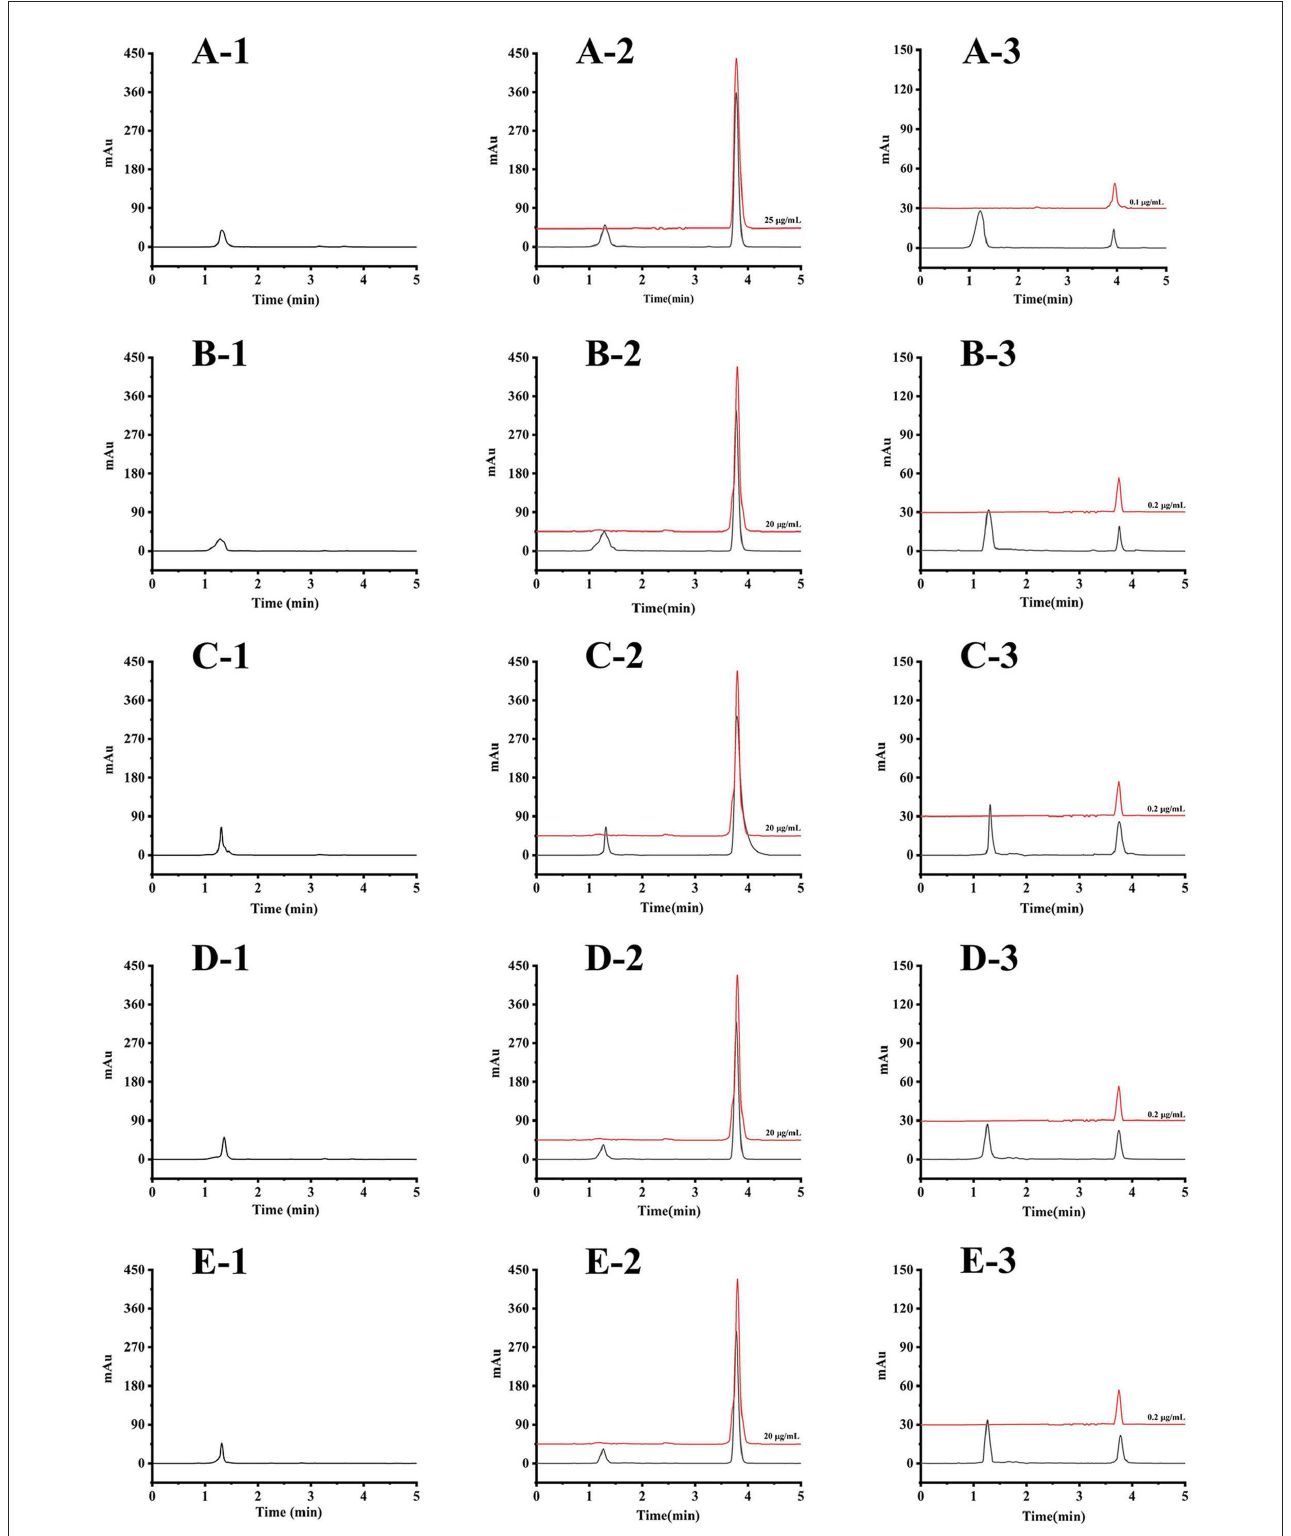
FIGURE1 The HPLC chromatograms of blank carp matrices spiked matrices (black line) and the corresponding standard solution (red line): (A-1) blank plasma, (A-2) plasma spiked at 10 µ g/ml and the standard solution of 25 µ g/ml, (A-3) plasma spiked at LOQ concentration and the standard solution of 0.1 µ g/ml; (B-1) blank muscle, (B-2) muscle spiked at 5 µ g/g and the standard solution of 20 µ g/ml, (B-3) muscle spiked at LOQ concentration and the standard solution of 0.2 µ g/ml; (C-1) blank brain, (C-2) brain spiked at 5 µ g/g and the standard solution of 20 µ g/ml, (C-3) brain spiked at LOQ concentration and the standard solution of 0.2 µ g/ml; (D-1) blank liver, (D-2) liver spiked at 5 µ g/g and the standard solution of 20 µ g/ml, (D-3) liver spiked at LOQ concentration and the standard solution of 0.2 µ g/ml; (E-1) blank kidney, (E-2) kidney spiked at 5 µ g/g and the standard solution of 20 µ g/ml, (E-3) kidney spiked at LOQ concentration and the standard solution of 0.2 µ